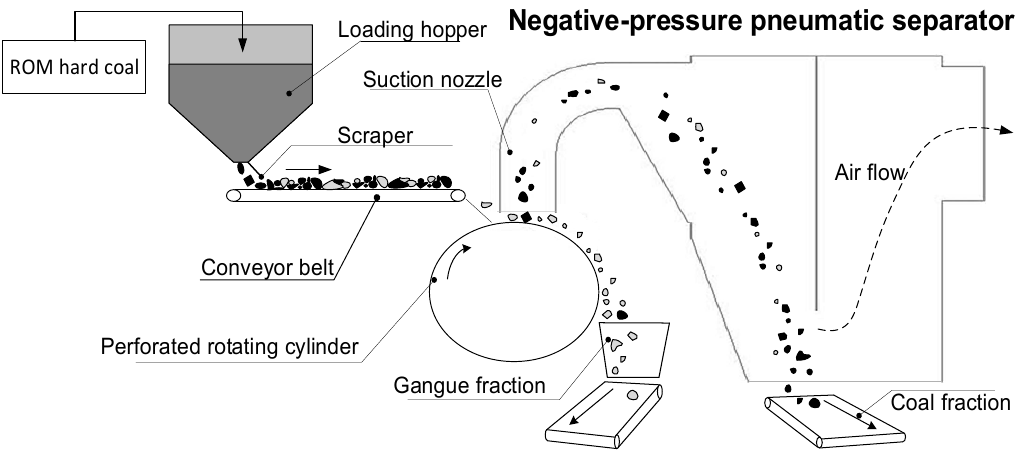
Figure 1. Principle of the negative pressure pneumatic separator (NPPS) operation [26].